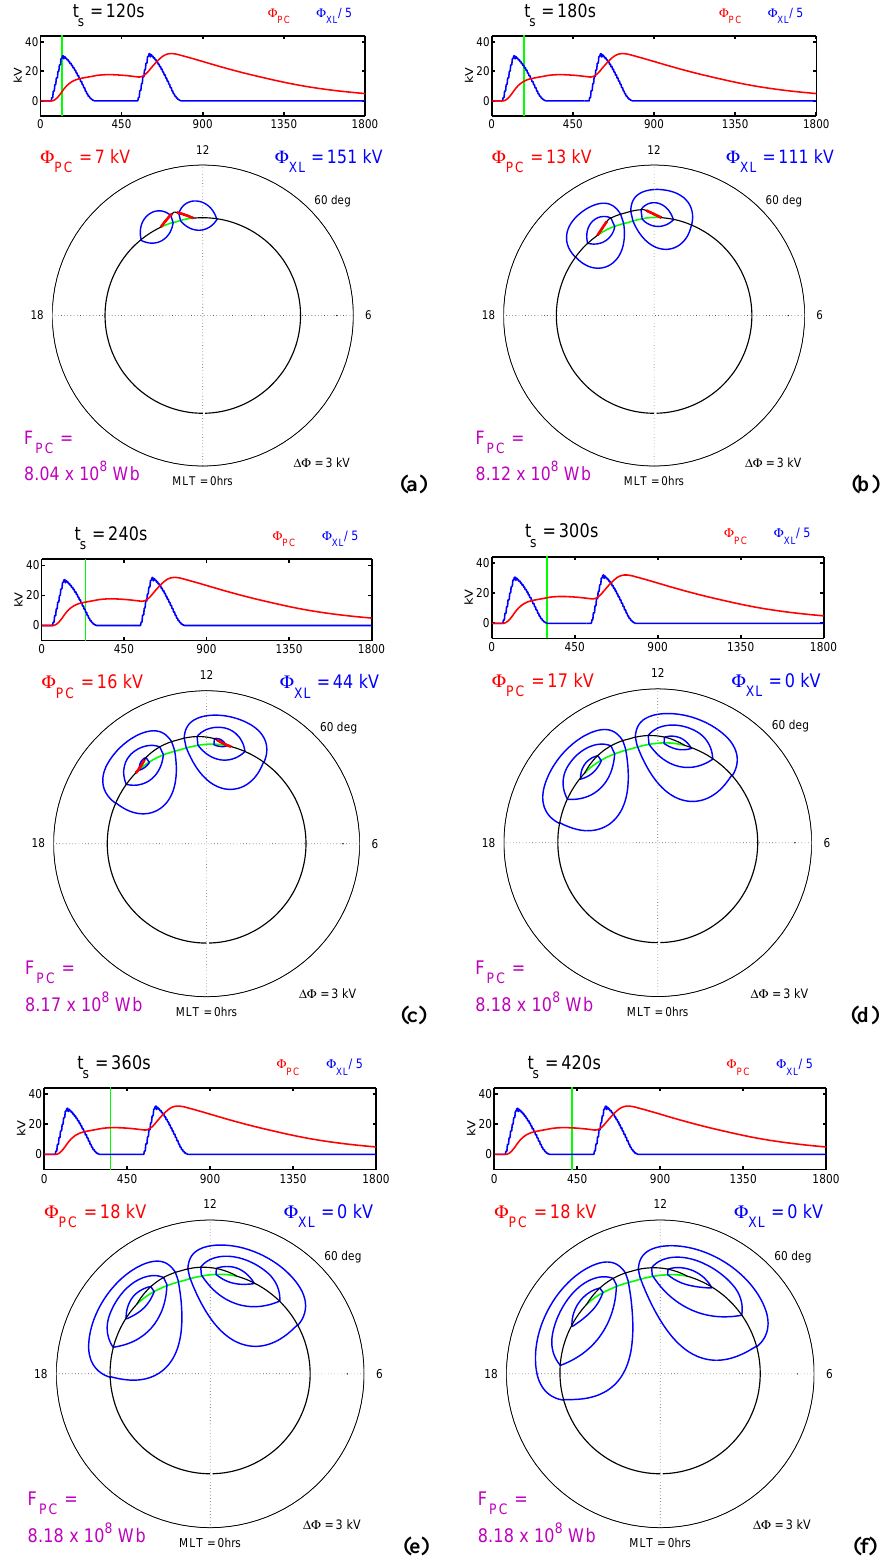
Fig. 7. Selected output convection patterns, each frame using the same format as Fig. 6. Note that the frames are not equally spaced in simulation time, t s